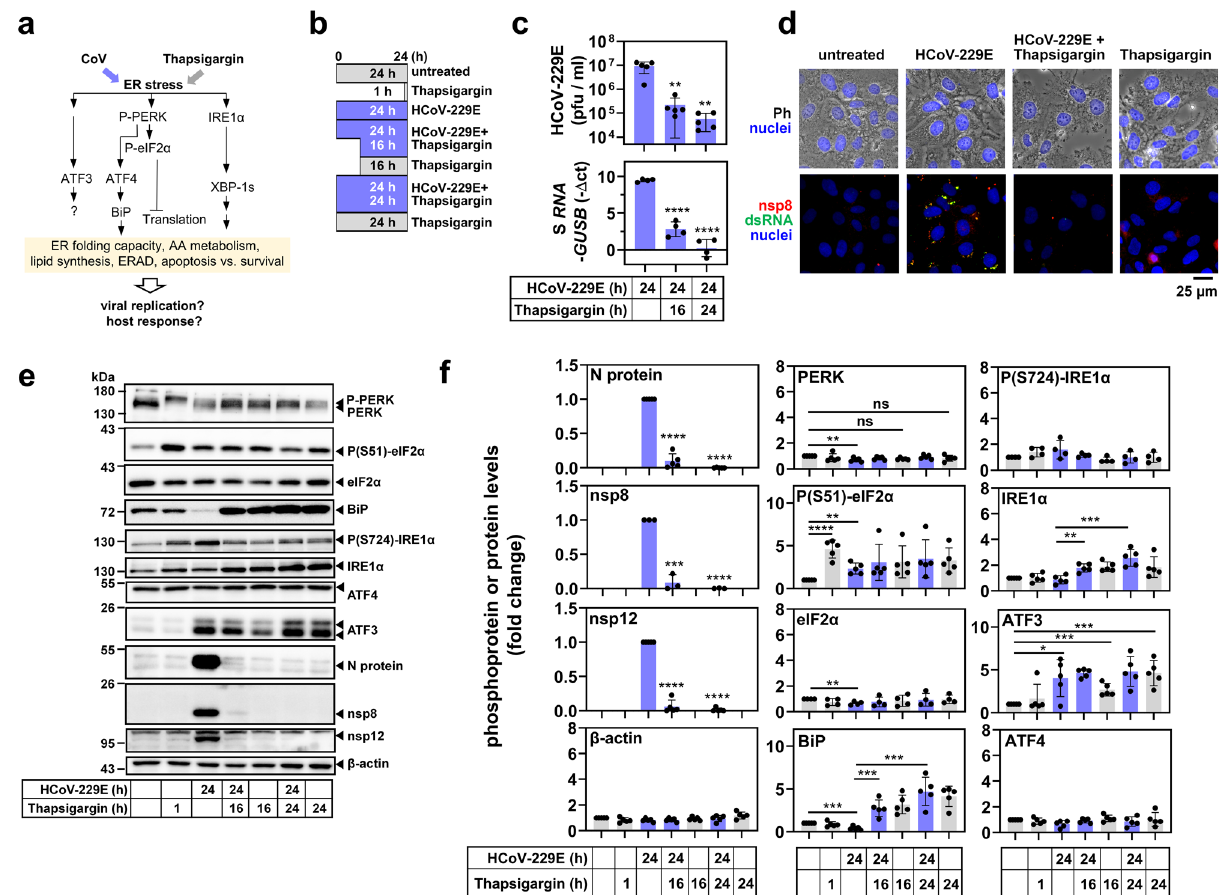
Fig. 2 Thapsigargin inhibits HCoV-229E replication and counteracts virus-mediated BiP downregulation. a Schematic overview of parameters used to monitor virus- and thapsigargin-mediated ER stress. b Schematic presentation of HCoV-229E infection of cells and/or treatment with thapsigargin as applied in this study. c HuH7 cells were left untreated or infected with HCoV-229E (MOI = 1) for 24 h and treated with thapsigargin (1 µ M) according to the scheme shown in ( b ). Supernatants and RNA isolated from the cell pellets were used to determine viral titers by virus plaque assay and expression of HCoV-229E S gene-encoding RNA ( fi ve (upper graphs) or four (lower graphs) biologically independent experiments). d Phase-contrast (Ph) and fl uorescence microscopy images showing the morphology of HuH7 cells and the subcellular HCoV-229E replication sites (at 24 h p.i.) identi fi ed by nsp8- and double-strand RNA-speci fi c antibodies in the presence or absence of thapsigargin (1 µ M for 24 h) (representative images from one out of two biologically independent experiments). Nuclei were stained with Hoechst 33342. e Representative immunoblots of total cell extracts from HuH7 cells infected with HCoV-229E (MOI = 1) and treated with thapsigargin (1 µ M) according to ( b ) showing the expression/modi fi cation of the indicated host cell and viral proteins. f Quanti fi cation of immunoblot data as shown in ( e ) relative to the untreated control (three or more biologically independent experiments). All bar graphs show means ± s.d.; asterisks indicate p values (* p ≤ 0.05, ** p ≤ 0.01, *** p ≤ 0.001, **** p ≤ 0.0001) obtained by